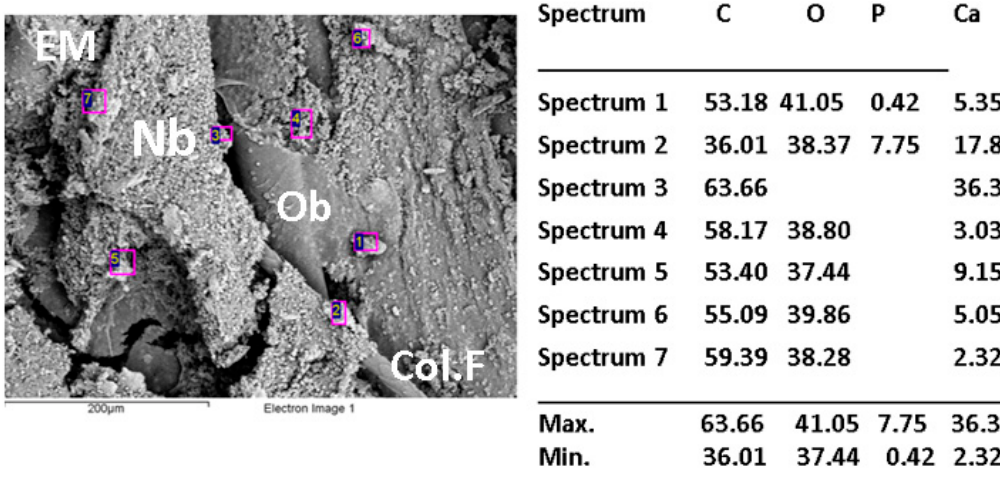
Figure 6. Scanning electron microscopy (SEM)/dispersive energy spectroscopy (EDS) analysis of CS-GO 0.5% sample implanted in critical size defects in rat parietal bone Wistar. Nb: Newly born bone. EM: Extracellular matrix. Col-F: collagen fiber. Ob: Osteoblast.